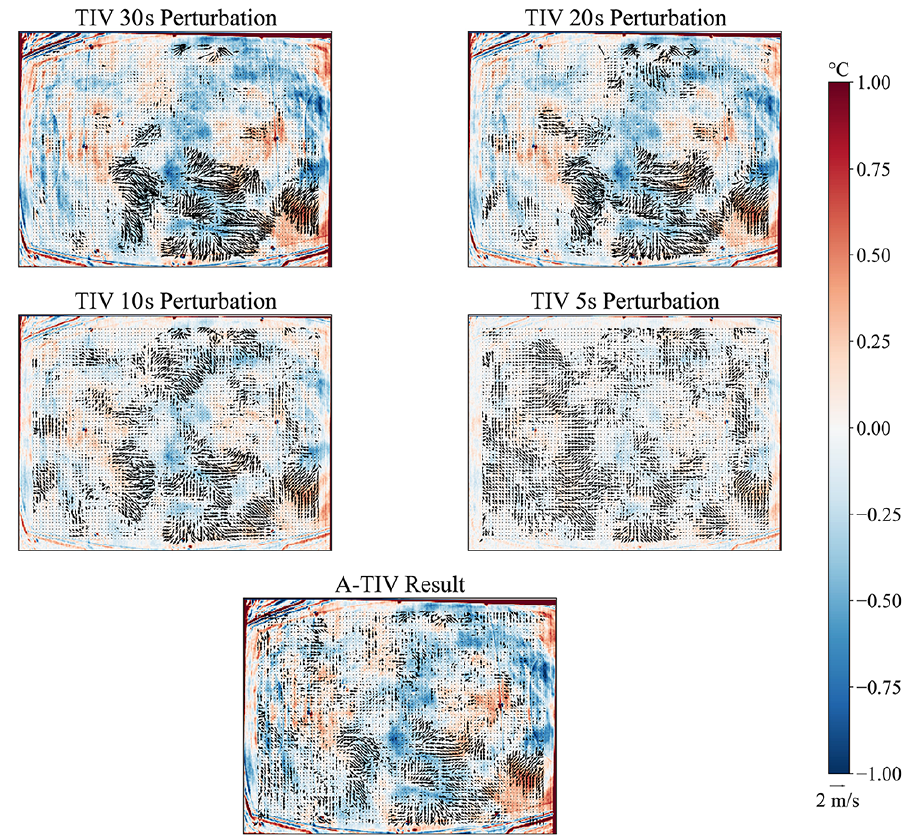
Figure 7. TIV from four different temporal running filter sizes – extraction of TIV vectors from the four perturbation temporal running filter sizes 30–5s. It is evident that with decreasing temporal running filter size more vectors are calculated. Table 3. Comparison of A-TIV with TIV – further qualitative information is also available in Appendix B.